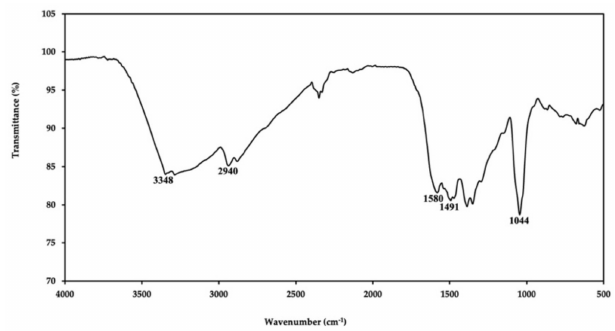
Figure 2. ATR-FTIR spectrum of synthesized